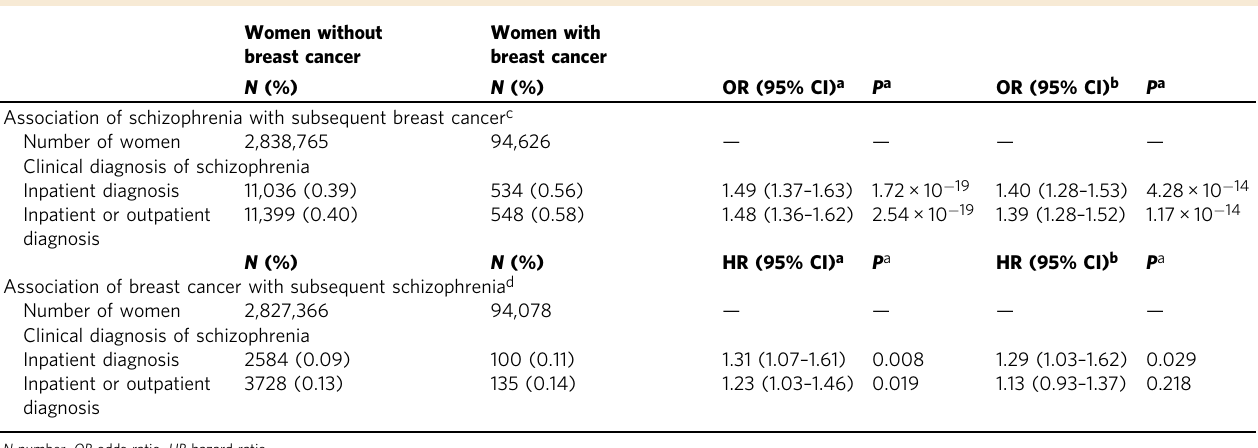
Table 1 Longitudinally bidirectional association between invasive breast cancer and schizophrenia.